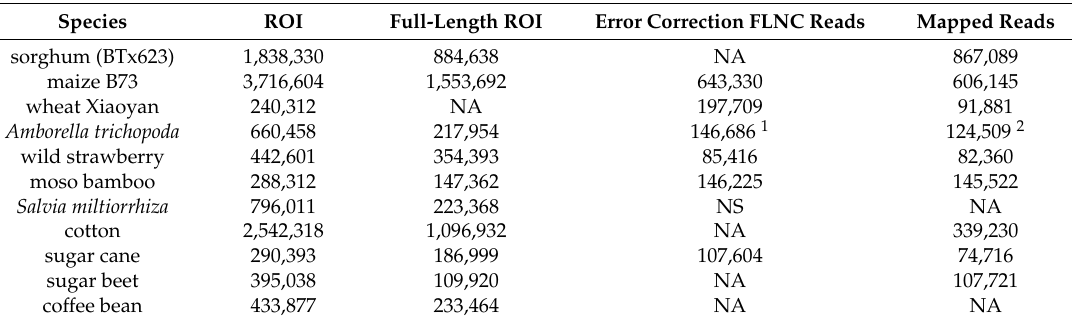
Table 2. Sequencing depth in